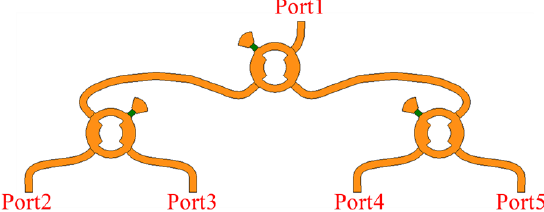
Figure 5: Simulated and measured results of the 4-to-1 power combiner.